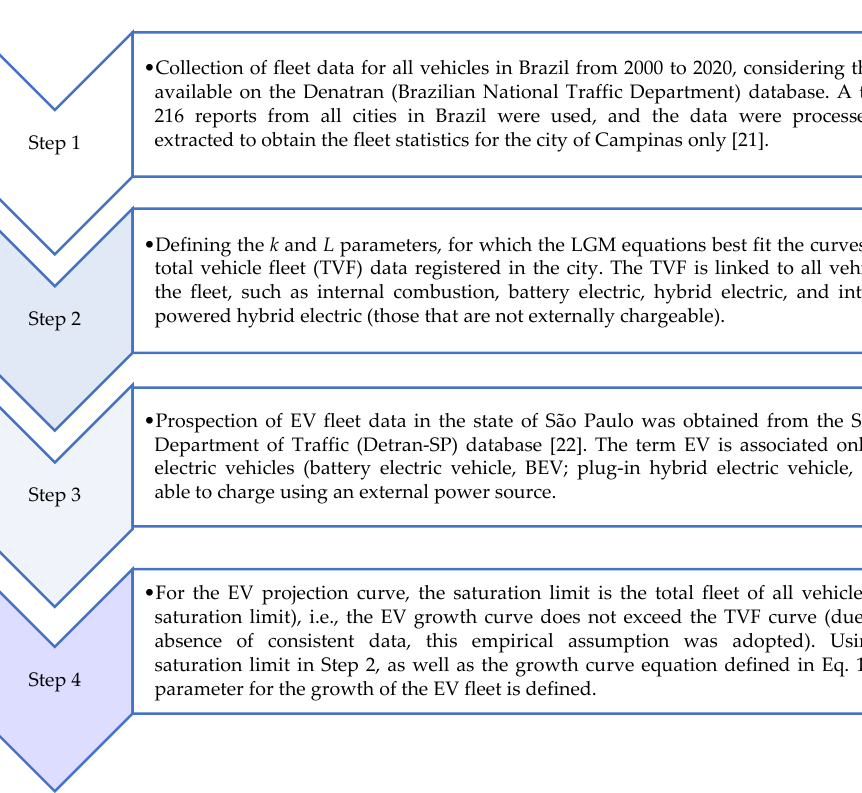
Figure 5. Flowchart of step-by-step procedure to estimate electric vehicle fleet based on available databases [21,22].